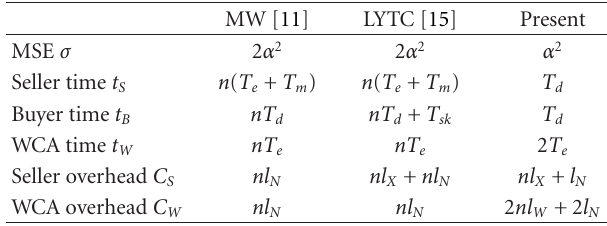
Table 1: Performance comparison.